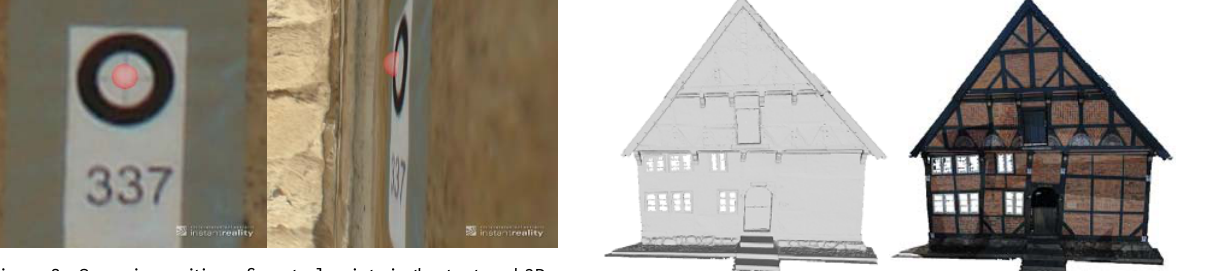
Figure 11. 3D model of the town house in Bad Segeberg, without texture (left) and with texture (right)